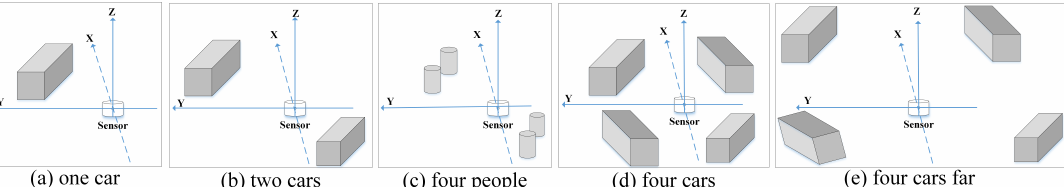
Figure 9. The diagram of the five different dynamic patterns used in semi-physical simulation. By comparing ( a , b , d ), we can analyze the influence of number of dynamic objects on performance of SLAM. By comparing ( b , c ), we can analyze the impact of shape of the objects on SLAM performance. The influence of distribution on SLAM can be obtained by comparing ( d , e ).